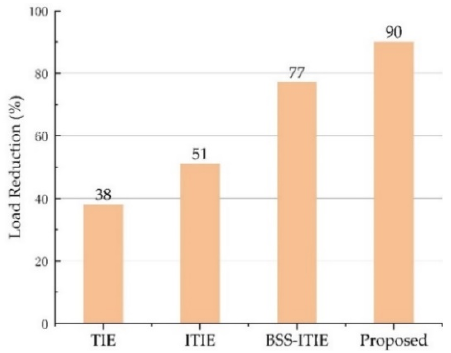
Figure 4. Bar graph representation of Table 4.